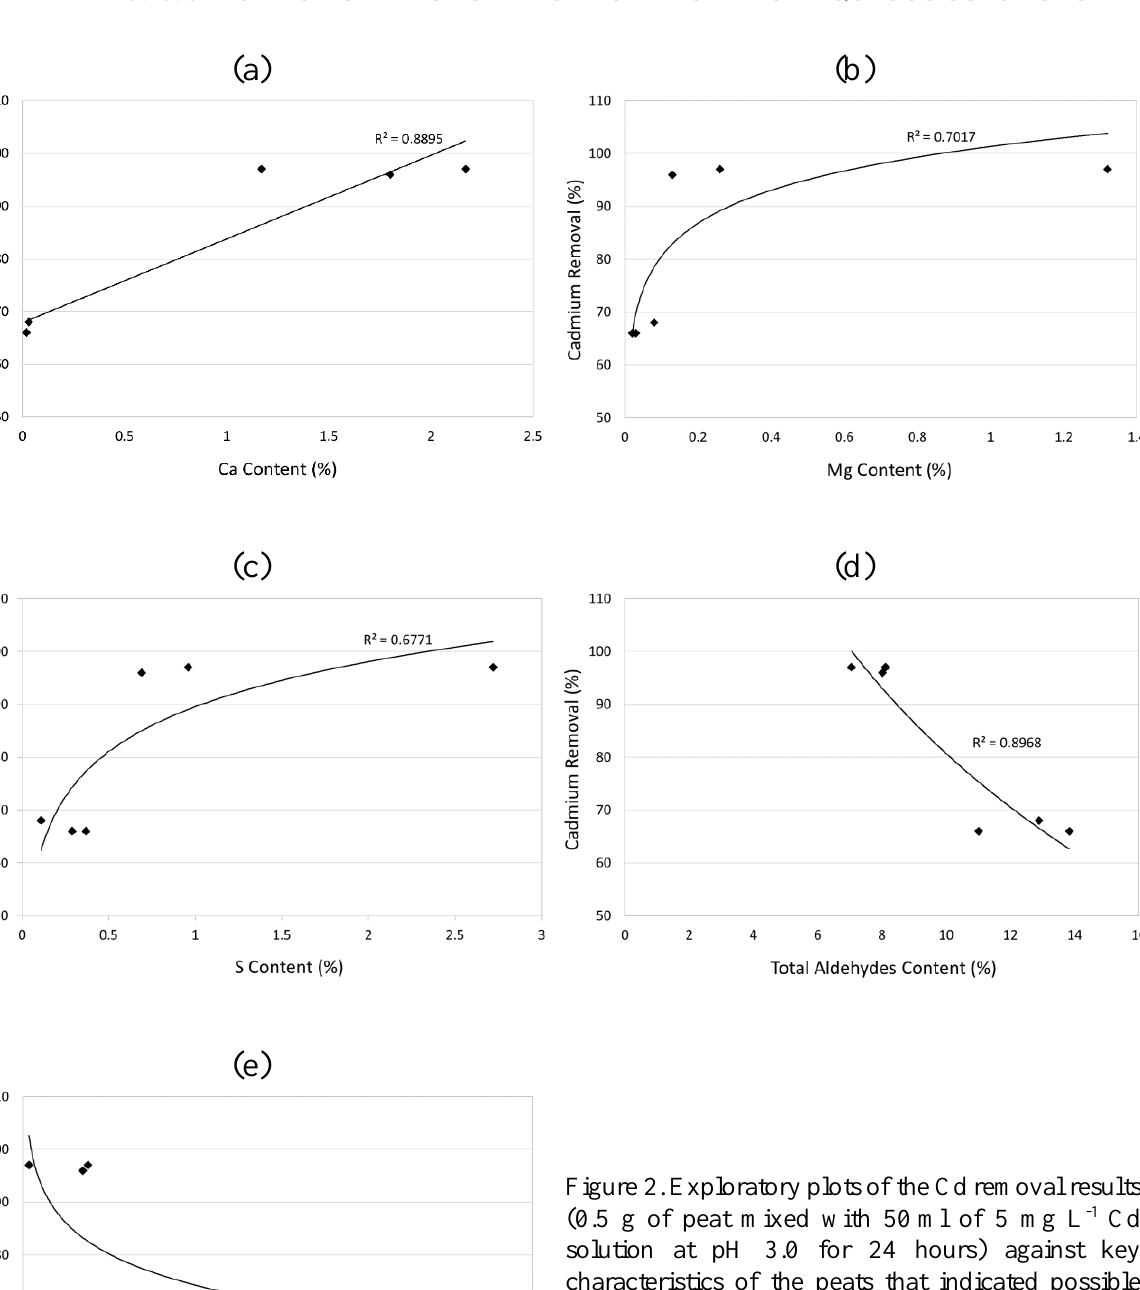
Figure 2. Exploratory plots of the Cd removal results (0.5 g of peat mixed with 50 ml of 5 mg L -1 Cd solution at pH 3.0 for 24 hours) against key characteristics of the peats that indicated possible relationships. The peat characteristics are: (a) calcium content; (b) magnesium content; (c) sulphur content; (d) total aldehydes content; and (e) the quotient (humic acids content ÷ fulvic acids